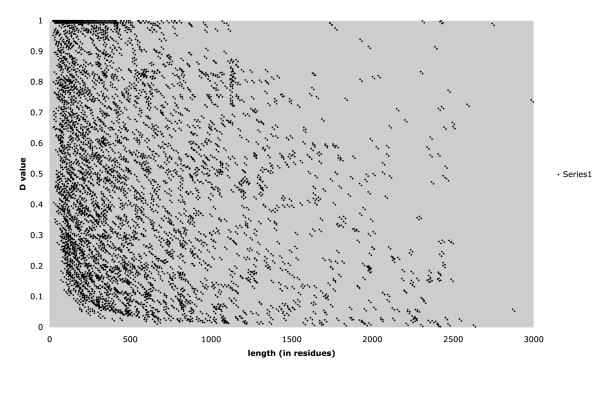
Plot of the D value versus the length of a CB region for the human proteome.